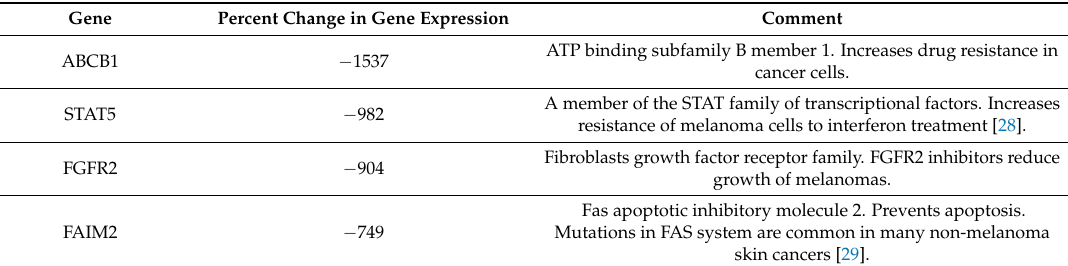
Table 4. GHK Downregulates Gene Expression in Some Cancer